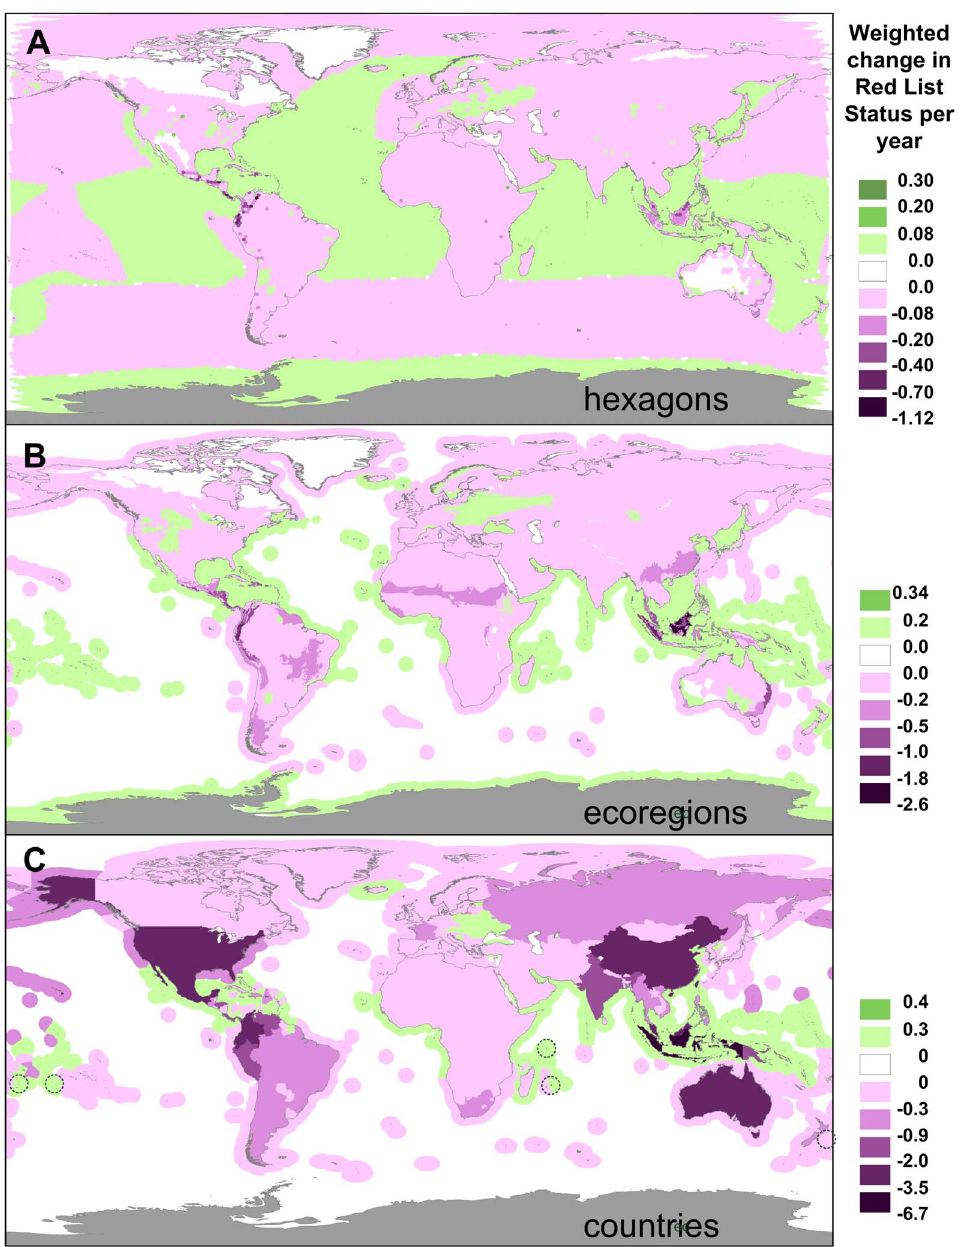
Figure 1. Spatially explicit trends in the global conservation status of vertebrates. Mapped as the variation across space in the weighted change in Red List status per year, across three types of spatial units: hexagons (equal-area, , 23,322 km 2 ), ecoregions (large biogeographic units). and countries (grouped according to sovereignty; e.g. New Caledonia within France). Magenta corresponds to spatial units that have made a net negative contribution to the global vertebrate conservation status as measured through the Red List Index, green to units that made a net positive contribution; grey regions (Antarctica) have no species. In (C), the island nations of Tonga, Cook Islands, Seychelles, Mauritius and Fiji (all with positive weighted change in the Red List status per year) are indicated by a dashed circle.